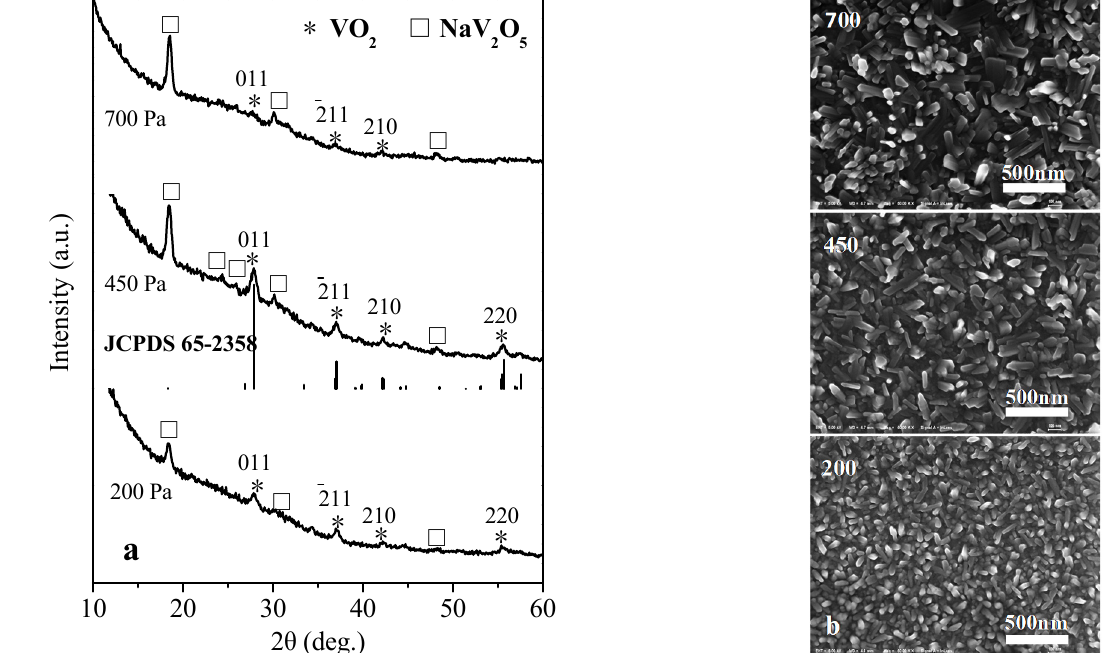
Figure 4. XRD patterns ( a ) and SEM images ( b ) of the VO 2 thin films prepared by professional an- nealing of 45 nm V films at 200, 450, 700 Pa respectively, 400 °C for 1 h. When the thickness of V film is reduced from 45 nm to 30 nm, the optimal annealing pressure is reduced to 100 Pa, as shown in Figure 5. In general, thicker V metal films require higher optimal annealing pressure to obtain large NIRSE, and thinner V metal films require lower optimal annealing pressure to obtain large NIRSE. The optical properties of the reduced VO 2 thin films are shown in Table 5.